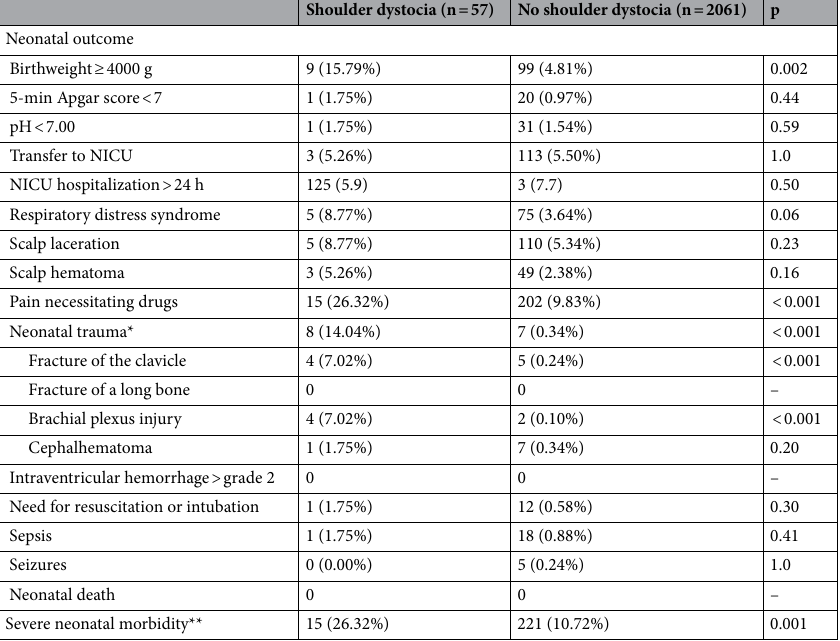
Table 2. Neonatal outcomes with and without shoulder dystocia at the time of an attempted operative vaginal delivery. *Neonatal trauma was defined by the existence of at least one of the following criteria: fracture of the clavicle or a long bone, brachial plexus injury and cephalhematoma. **Severe neonatal morbidity was defined by at least one of the following criteria: 5-min Apgar score < 7, umbilical artery pH < 7.00, need for resuscitation or intubation, neonatal trauma, intraventricular hemorrhage > grade 2, admission to the NICU (neonatal intensive care unit) for > 24 h, convulsions, sepsis, and neonatal death 27